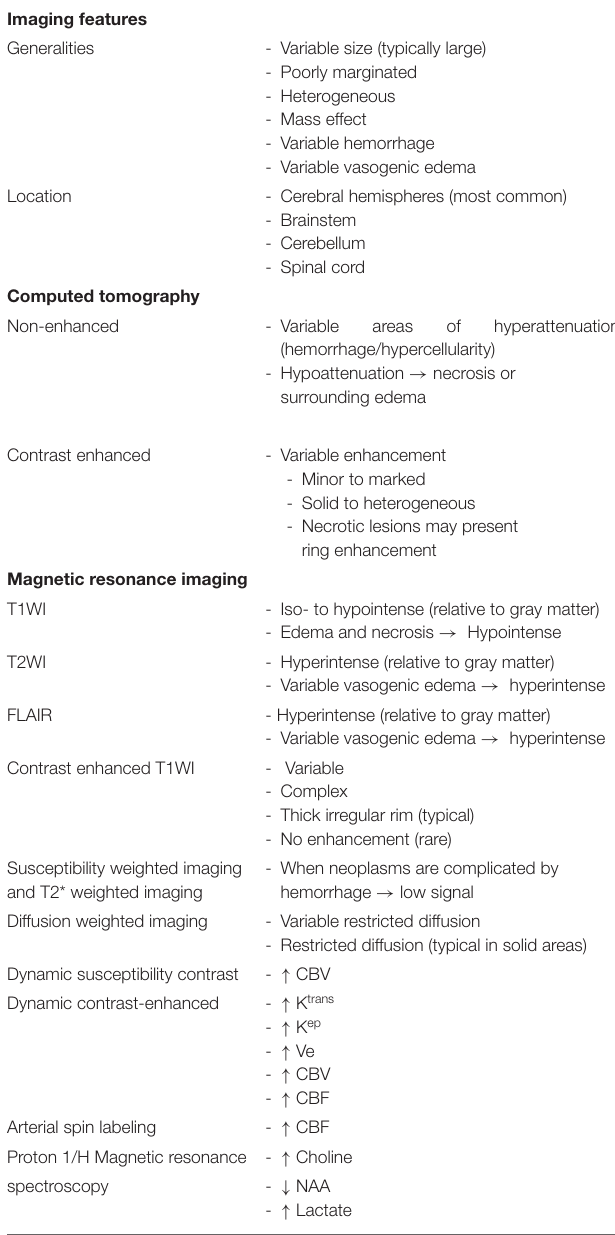
TABLE 1 | Typical computed tomography and magnetic resonance imaging features of pediatric glioblastomas. Imaging